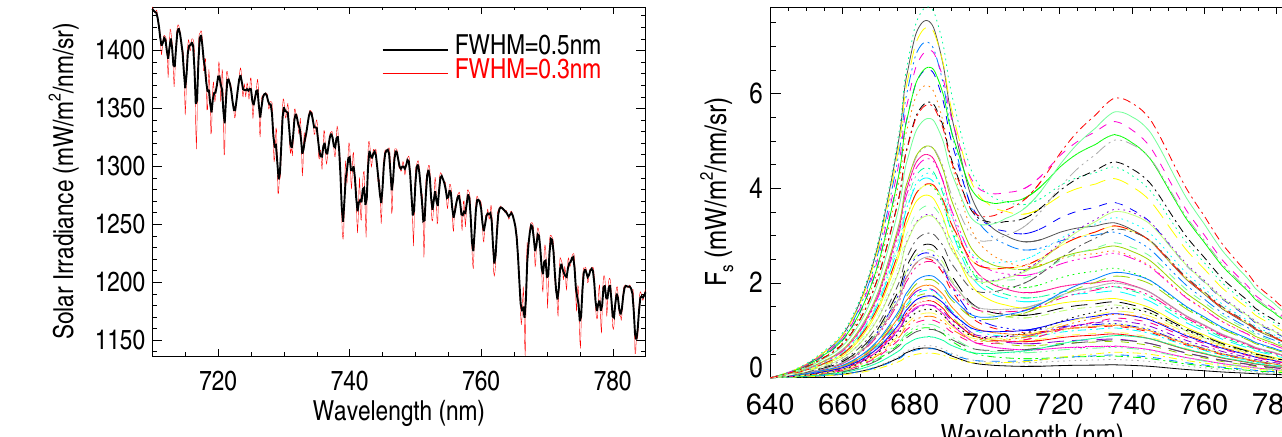
Fig. 3. Canopy-level spectral fluorescence as specified for the range of conditions in the simulated data set.